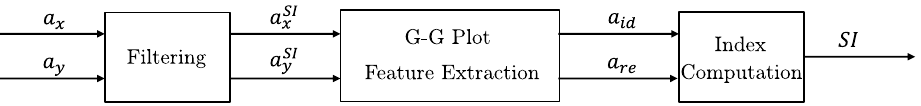
Figure 7. Block schemes representation of the Safety Index estimation